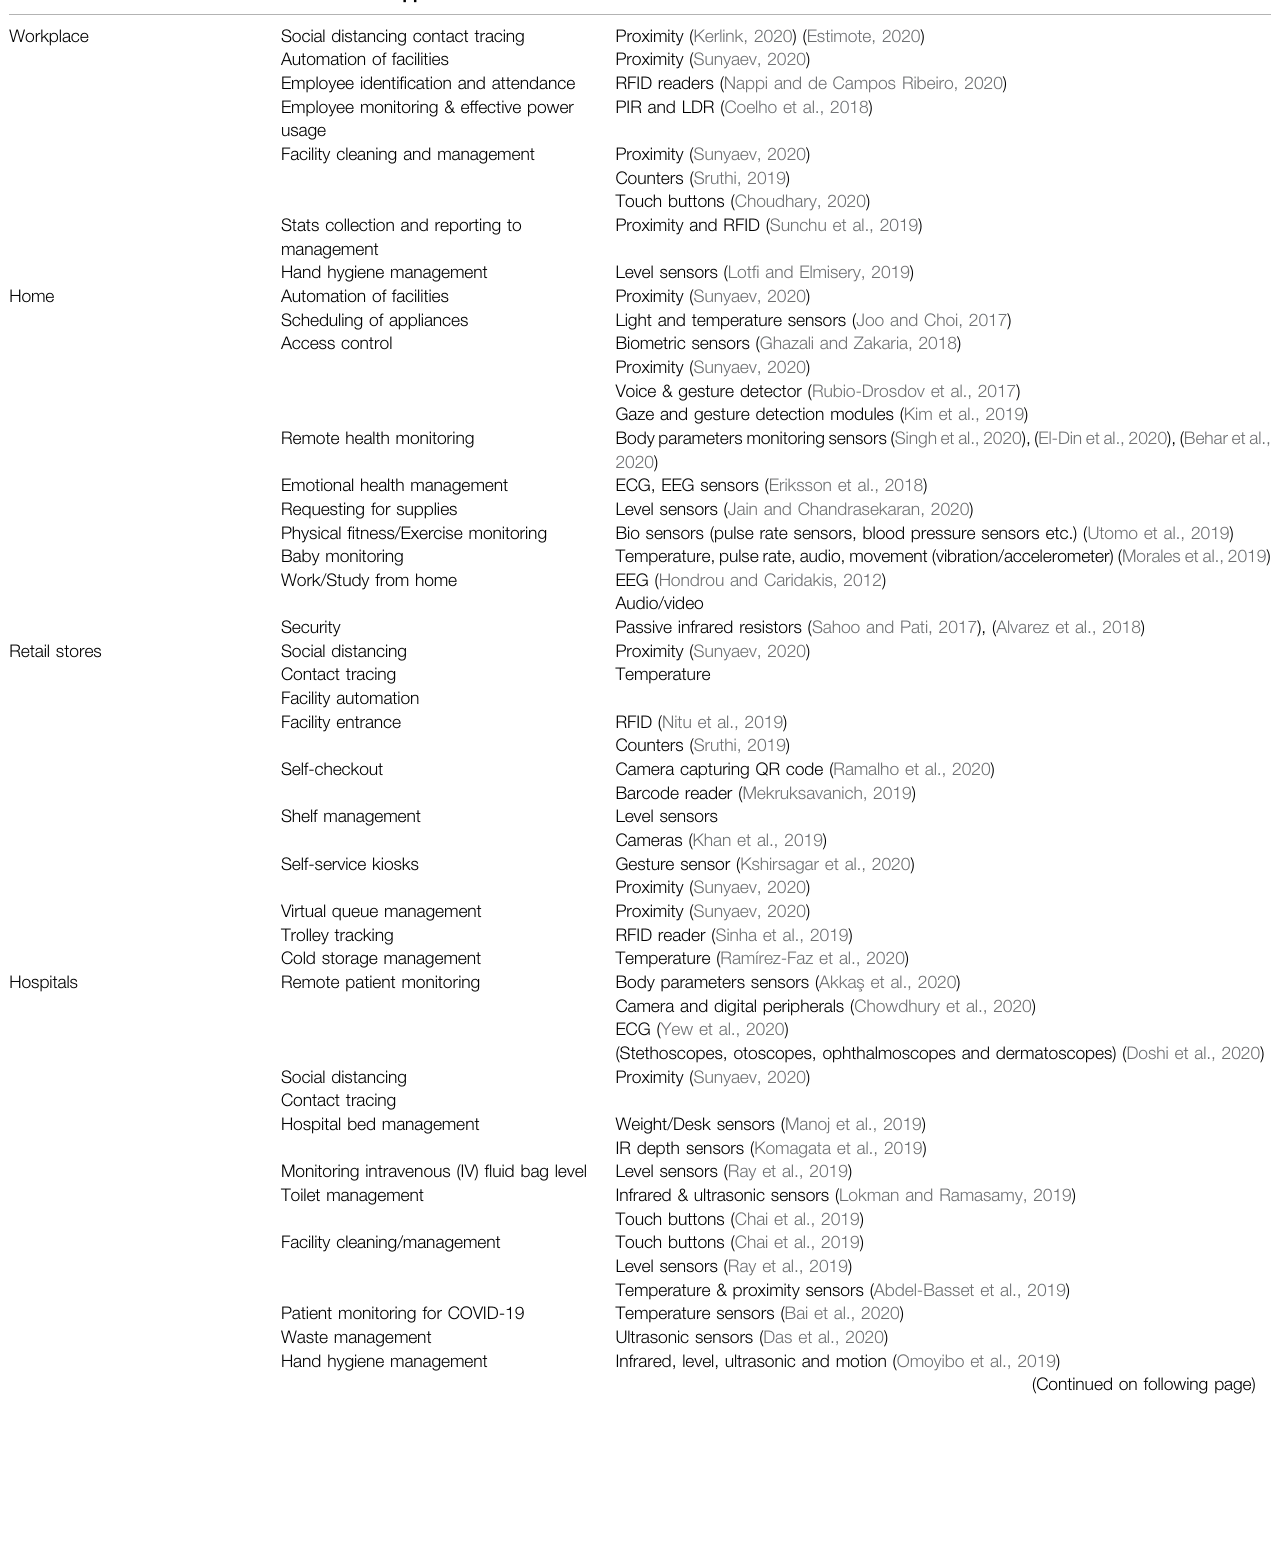
TABLE 1 | IoT Sensors for COVID-19